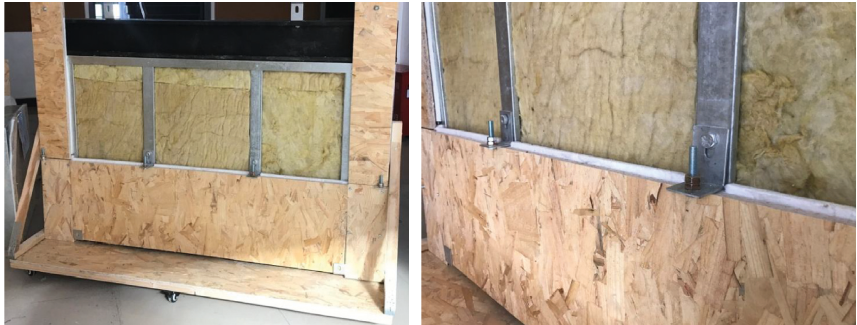
Figure 11: Full-scale model and connection details (source: authors’ own data).